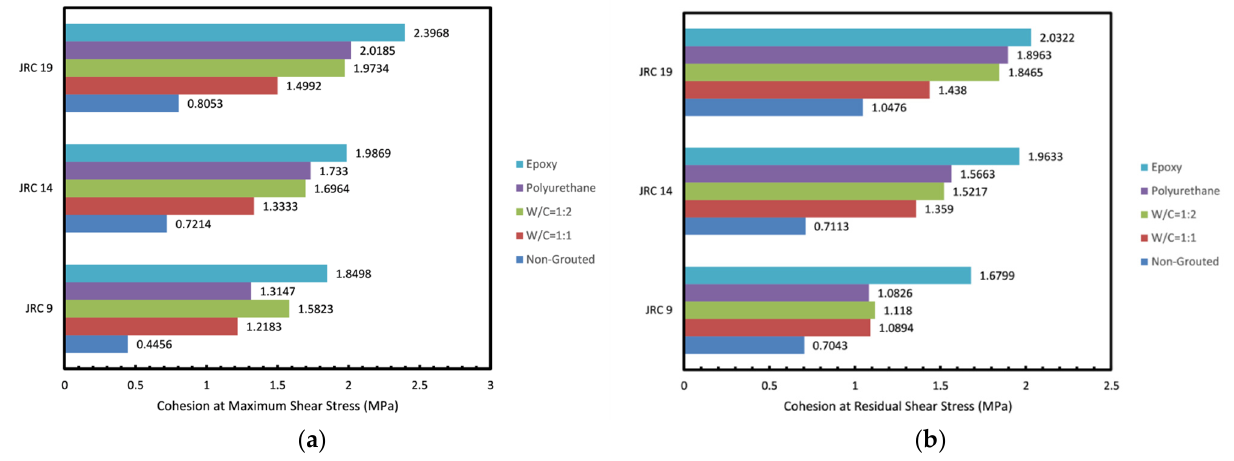
Figure 7. ( a ) Cohesion at maximum and ( b ) Cohesion at residual shear stress obtained for the rock joints tested.